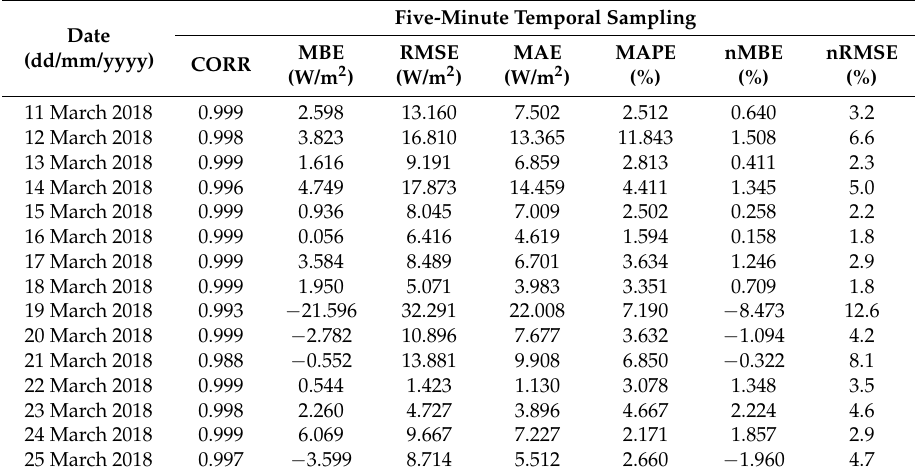
Table 3. Results of the statistical assessment for AMESIS product based on five-minute temporal sampling against ground measurements at the Tito site.